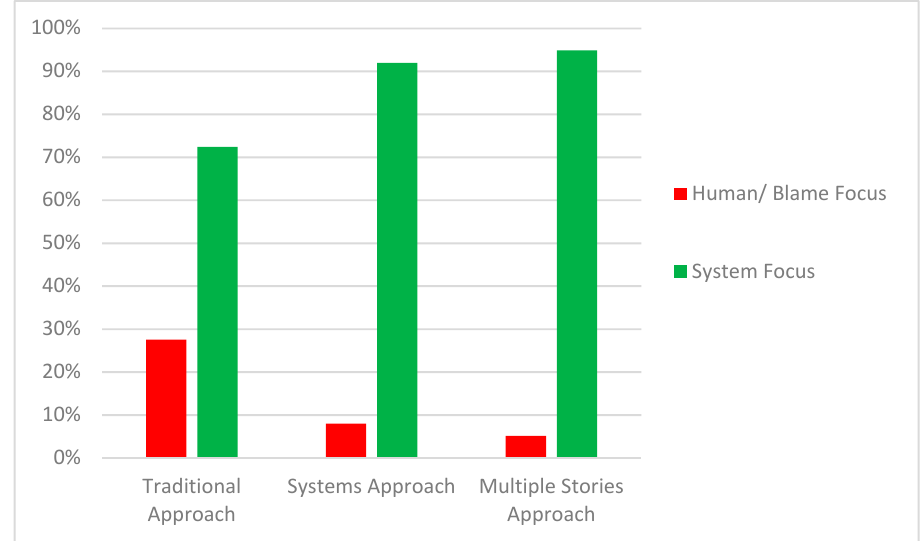
Figure 1. The figure above displays the percentage of human/blame-focussed recommendations against the percentage of system-focussed recommendations provided for each report variant.